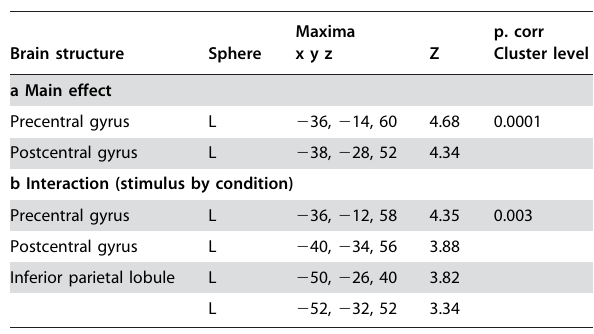
Table 3. Brain activity reflecting main effect (a) and interaction (b) of judged-as-ugly vs. judged-as-beautiful images. .. ... .... ... ... .... ... ... .... ... ... .... ... ... .... ... ... .... ... ... .... .